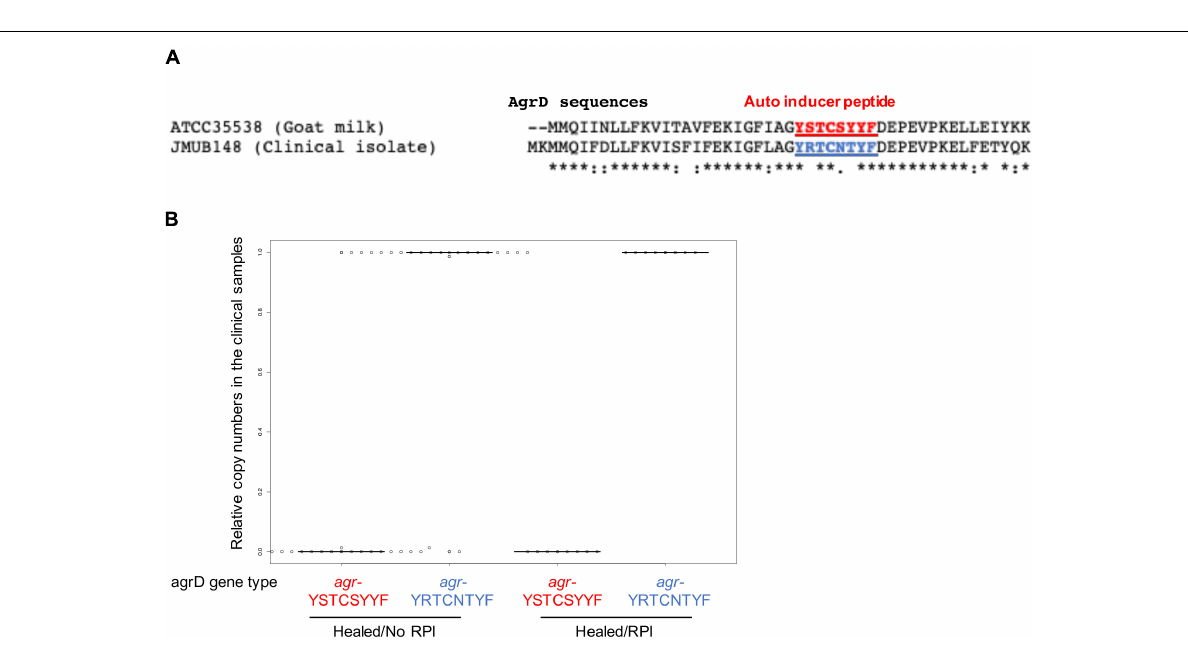
Frontiers in Microbiology |